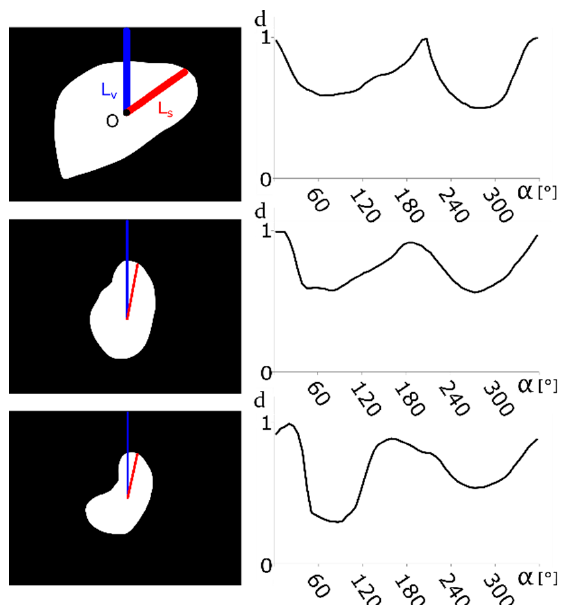
Figure 2. Examples of contours from the MDB. Left column: prerendered images of model position. Right column: Image descriptor d ( α ). The plots show the distance from geometric center of mass ( Y axis) with respect to the angular position of the point ( X axis). L s is the starting position for descriptor calculations, L v is the reference line used to determine the angle about the Z w axis, and O is the contour center of mass.